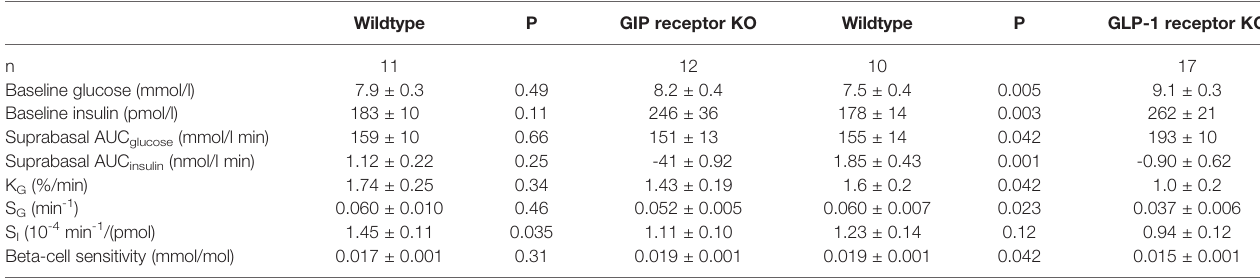
TABLE 1 | Baseline glucose and insulin, suprabasal area under the 50 min curve (AUC) of glucose and insulin, glucose elimination rate (K G ), glucose effectiveness (S G ), insulin sensitivity index